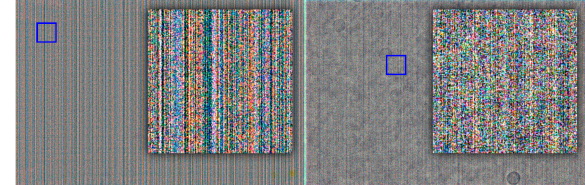
var(green) supressing random noise var(blue) supressing random noise var(red) supressing random + fixed noise var(green) supressing random + fixed noise var(blue) supressing random + fixed noise